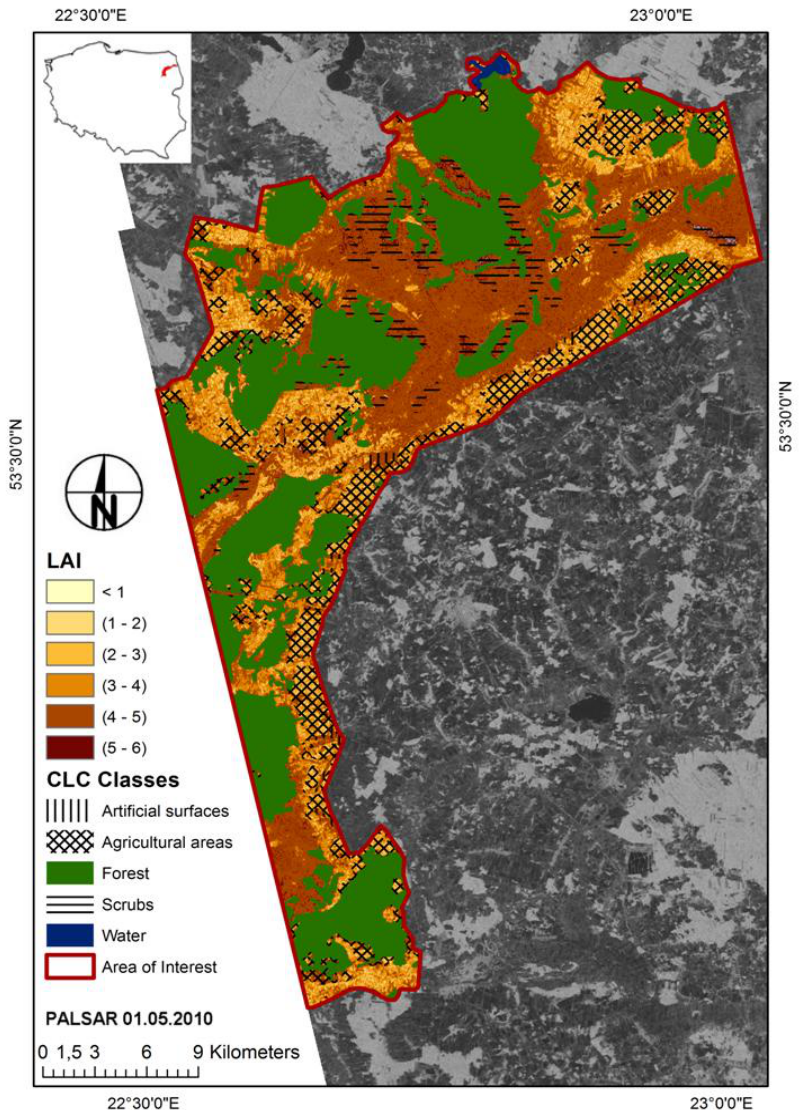
Figure 11. Map of LAI distribution on 1 May 2010 within the area of